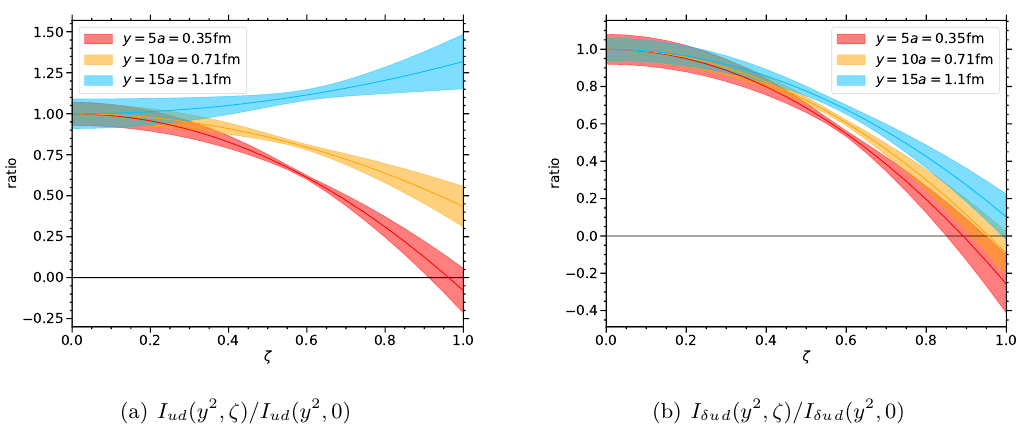
Figure 30 . Mellin moments of skewed DPDs as a function of ζ , reconstructed from our global fit and normalised to their value at ζ = 0